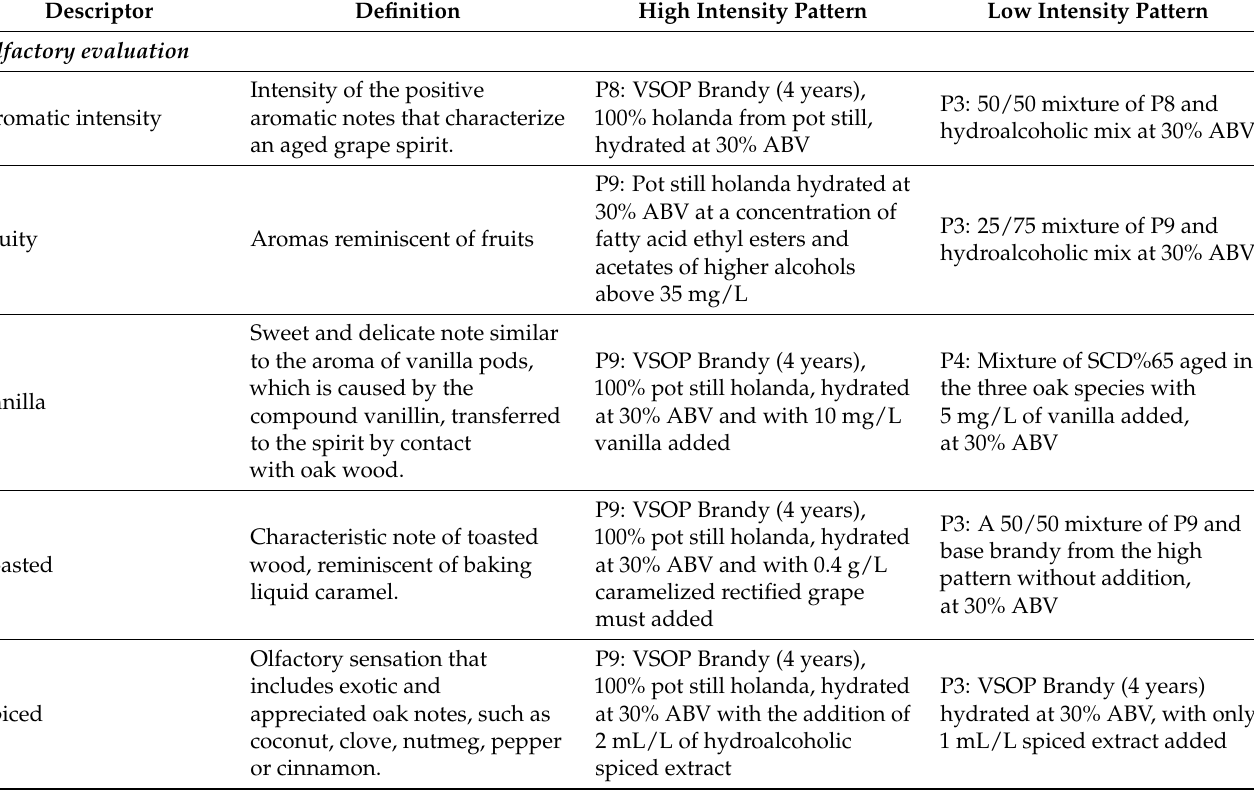
Table 7. Sensory descriptors selected for the assessment of the brandies, their definitions, and the standards used for the training of the panel. The hydroalcoholic mixtures were elaborated using 96% ABV neutral alcohol and demineralized